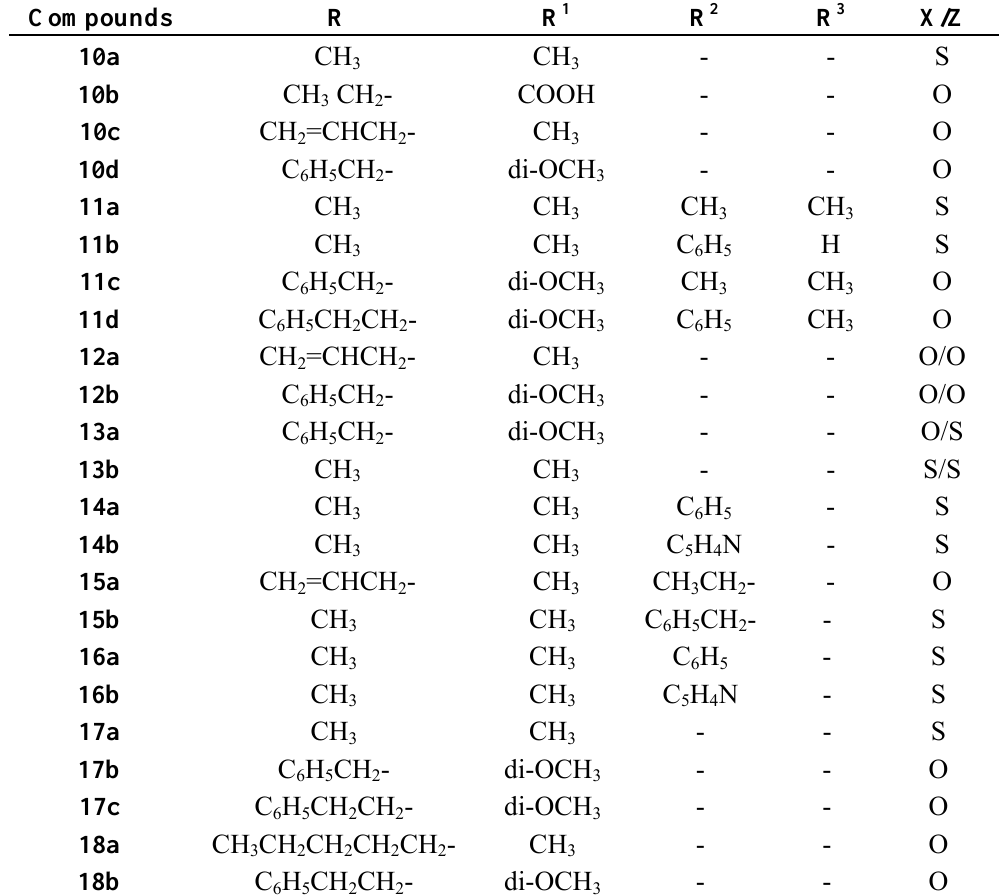
Table 2. Prepared compounds 10-18 .